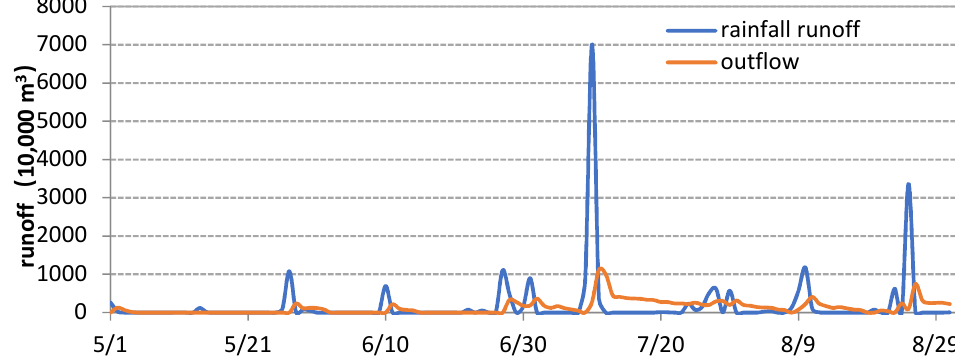
Figure 12. Comparison between daily rainfall runoff and outflow in the wet season (dry year, 95% ).